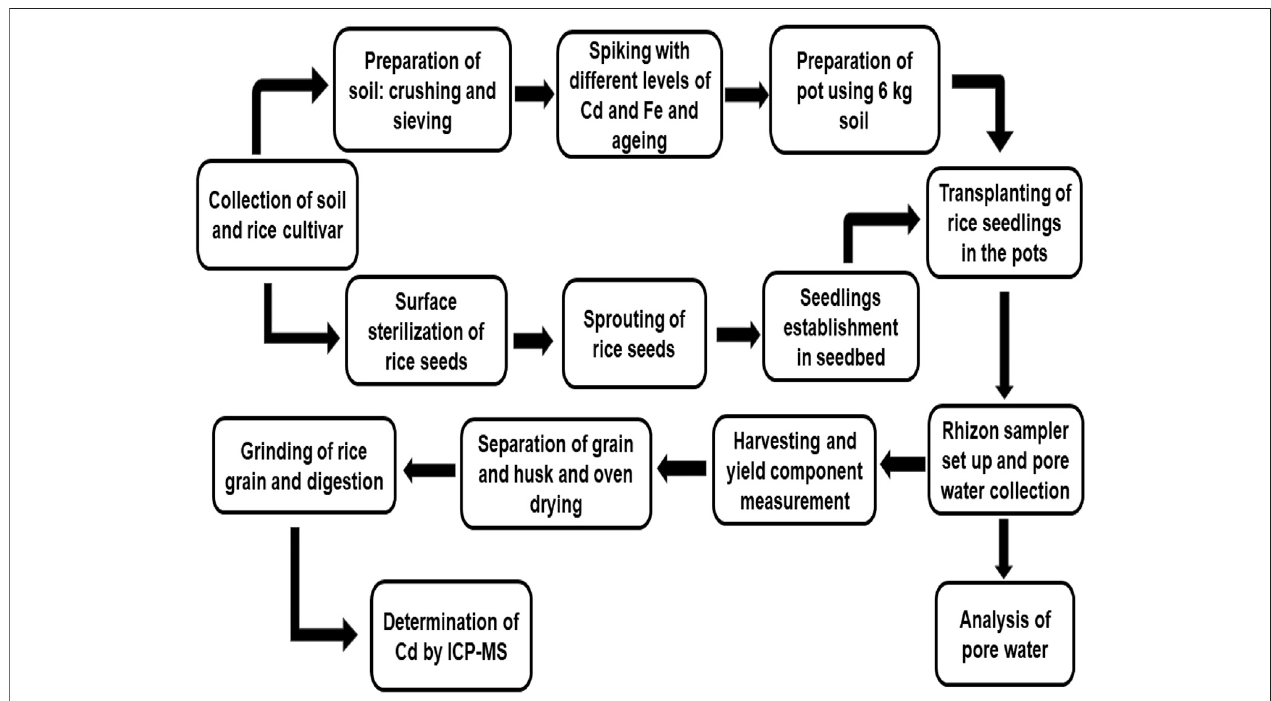
FIGURE 1 | Schematic diagram showing the entire experimental